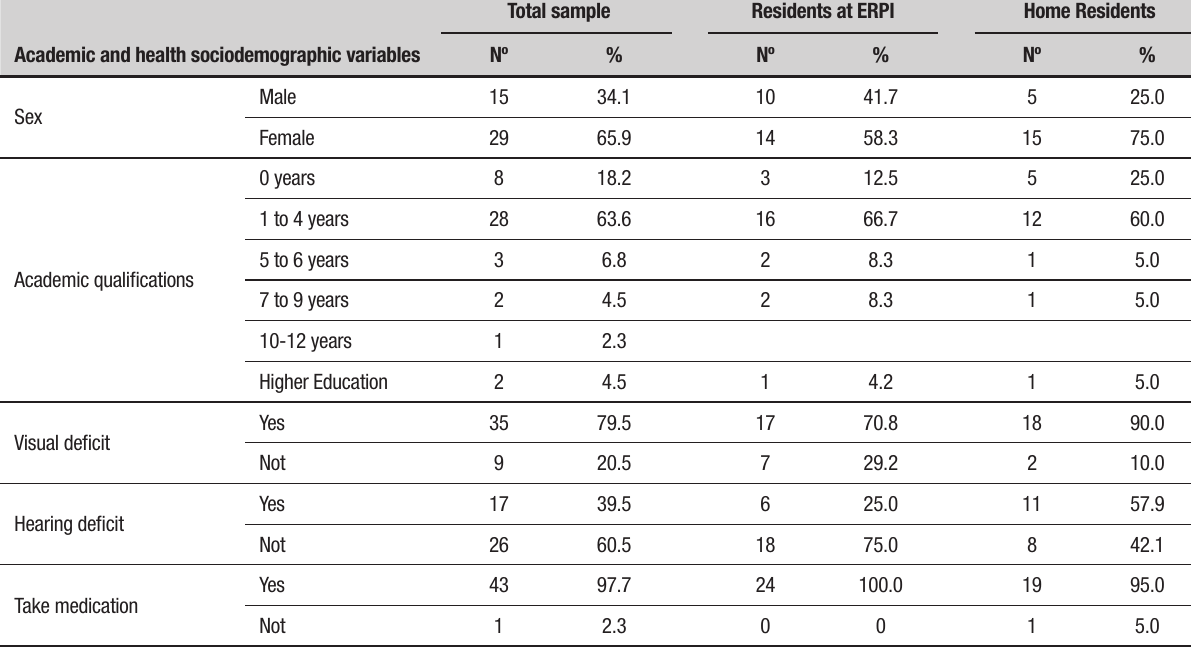
Table 1. Sample distribution regarding academic and health sociodemographic data.